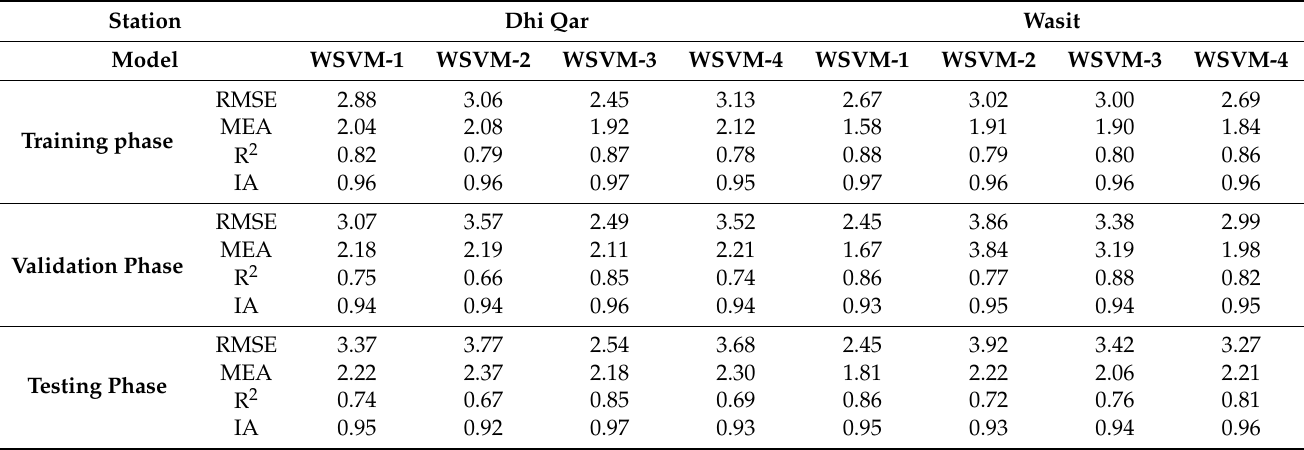
Table 3. The results of statistical analysis of different input patterns of WSVM model in Rs evaluation.